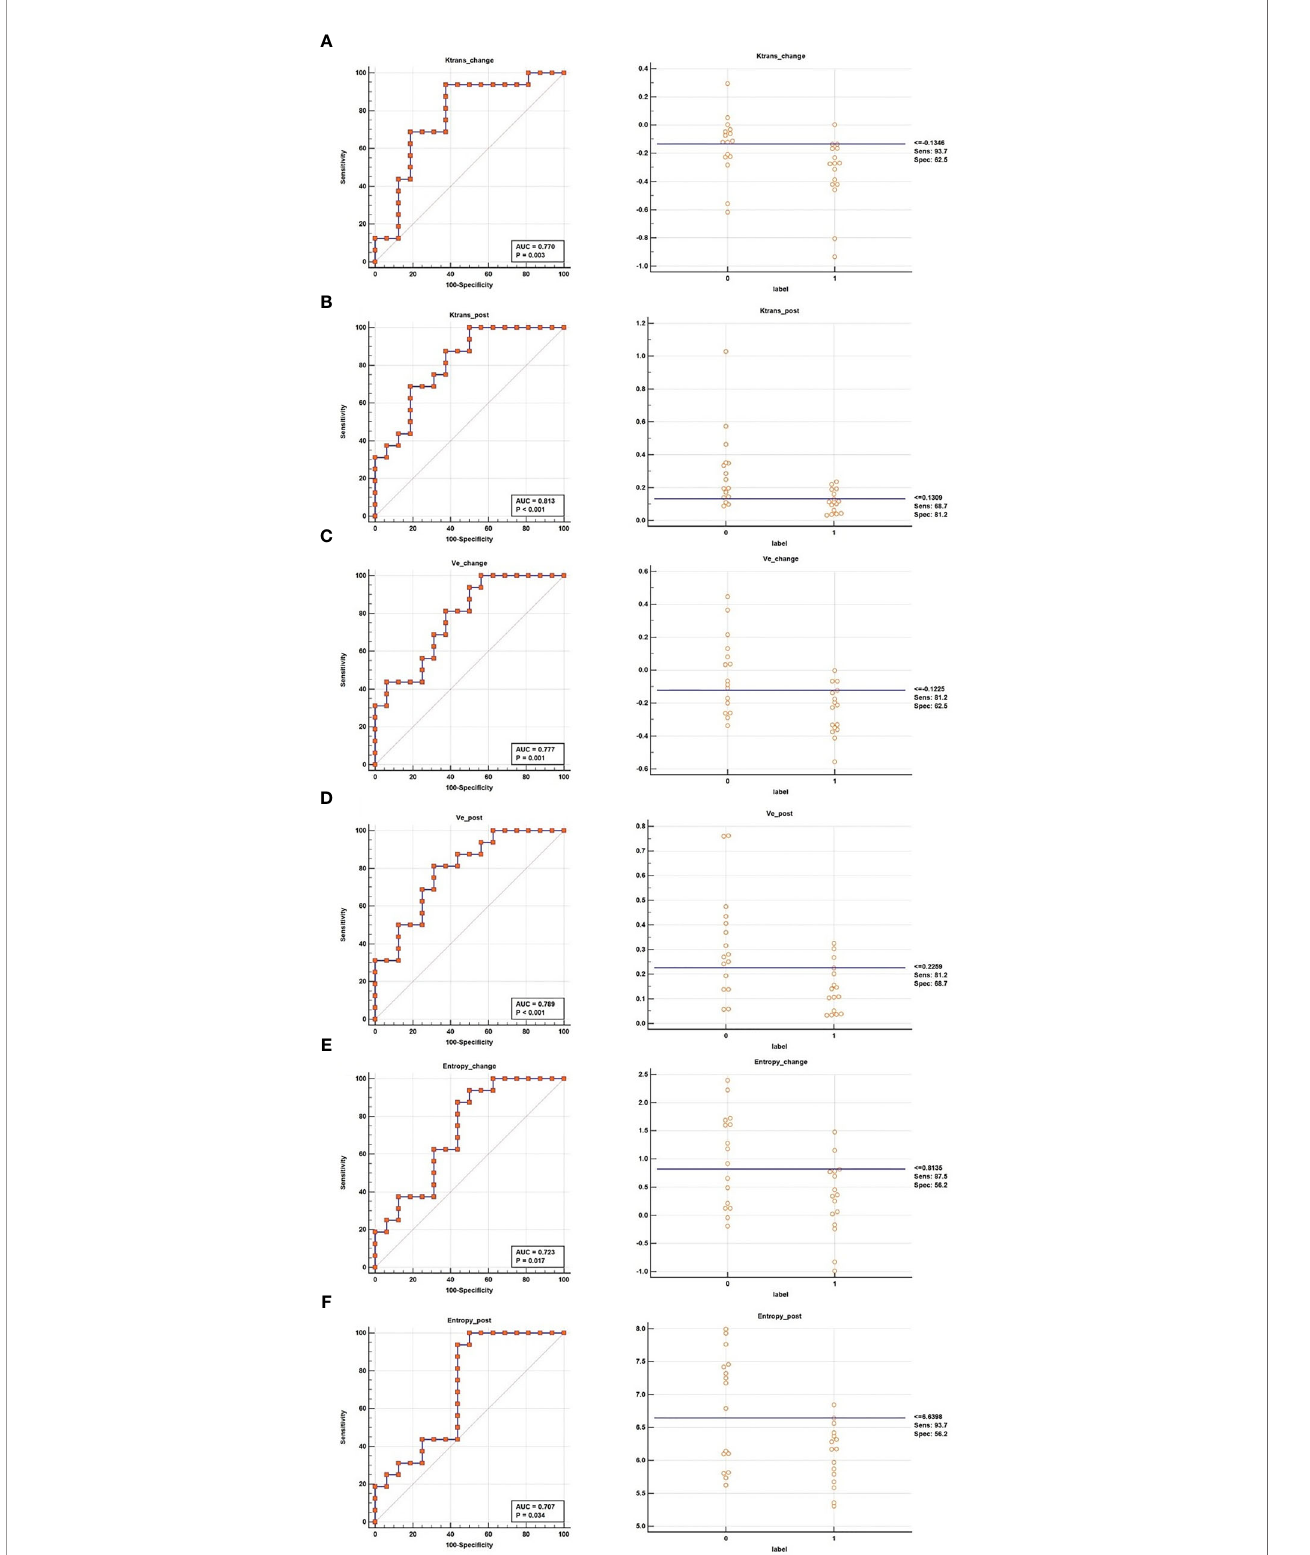
FIGURE 3 | ROC curves of Ktrans change (A) , Ktrans post (B) , ve change (C) , ve post (D) , entropy change (E) , and entropy post (F) for determining the response to